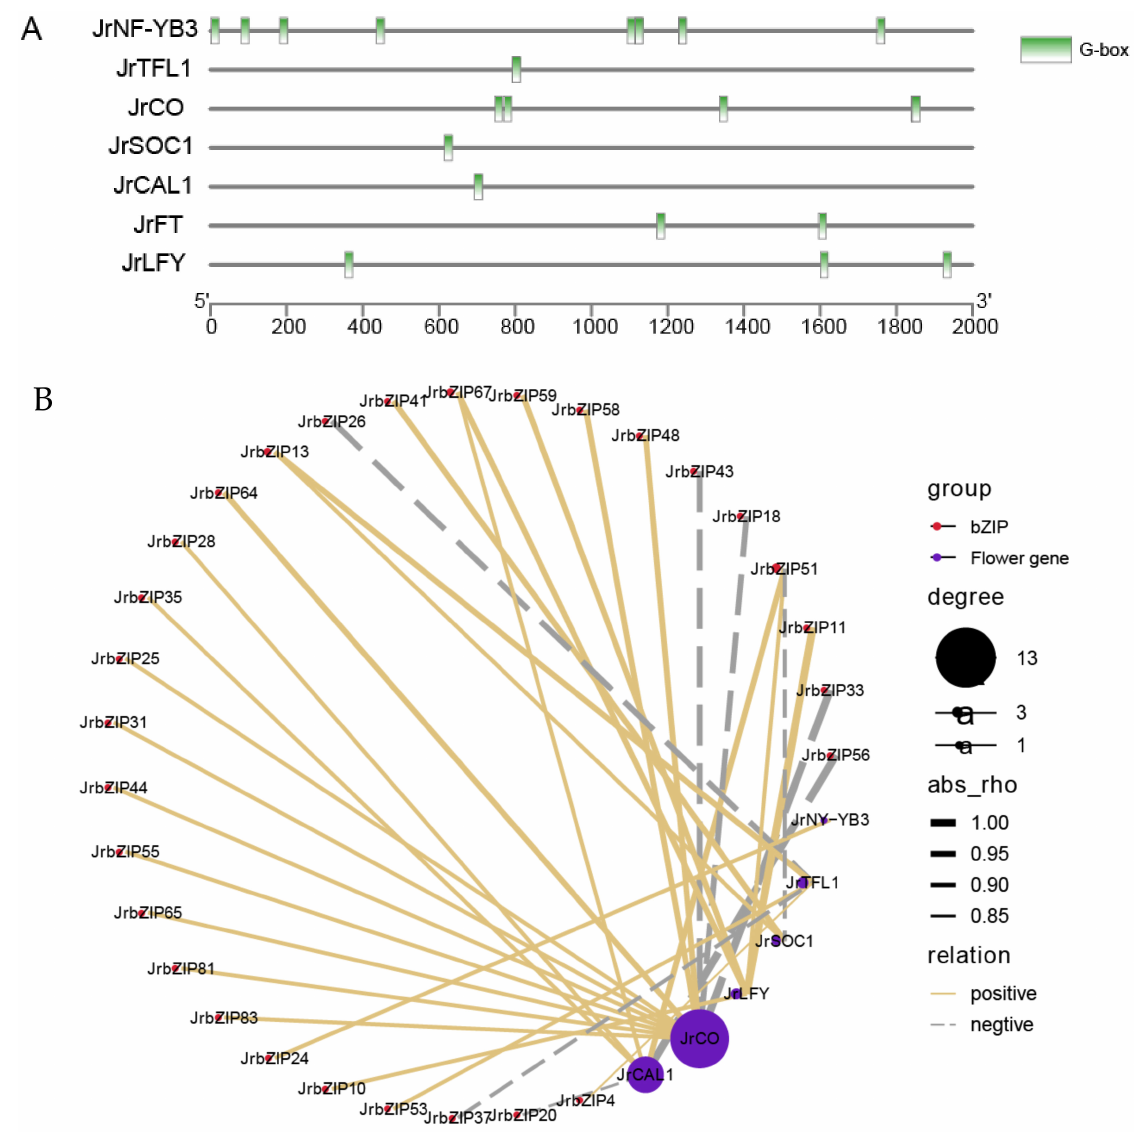
Figure 8. ( A ) The promoter sequences (2000 bp) of 7 flower genes were analyzed. The elements were identified as follows: green for the G-box element. ( B ) Co-expression network of 29 bZIP genes and 6 flowering genes in walnut. Co-expression network of 29 bZIP genes from walnut with six flowering genes. The genes (nodes) in red and blue ovals represent probes (flowering genes) and targets ( bZIP genes), respectively. Co-expression values are based on Pearson’s correlation coefficient ≥ 0.8, with a p value cutoff at 0.05. The lines in yellow and black indicate the positive and negative correlations between the two nodes,